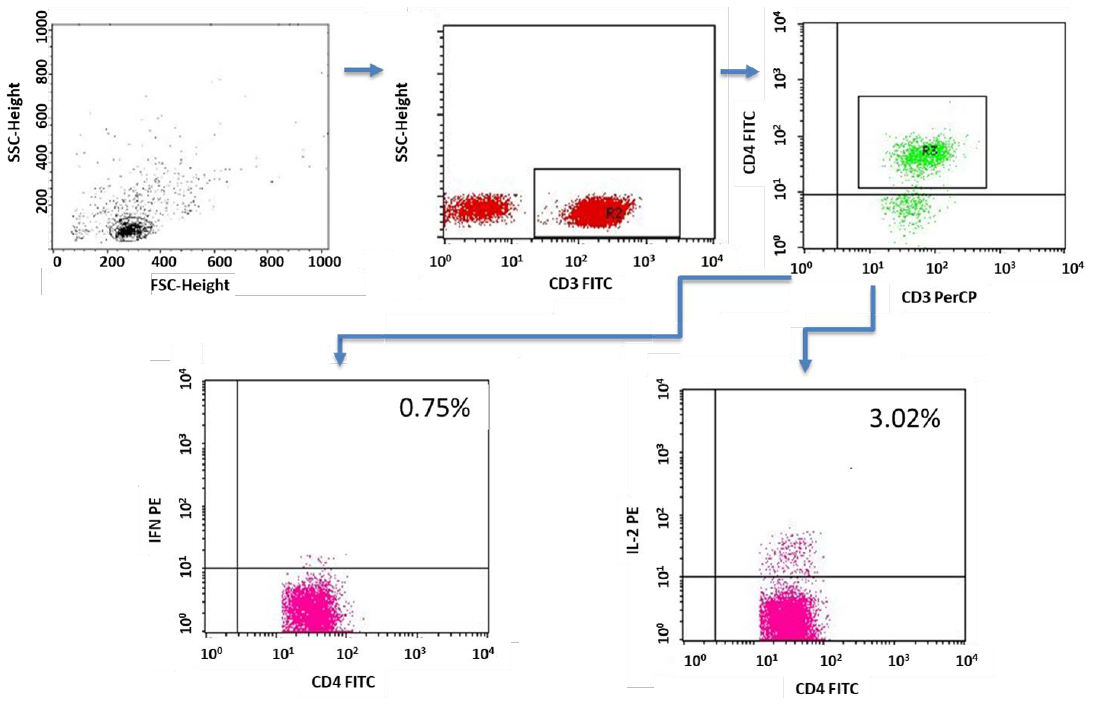
Figure 12. Sample analysis of the percentage of T lymphocytes with the CD4+CD3+IFNγ+ and CD4+CD3+IL-2+ phenotypes.